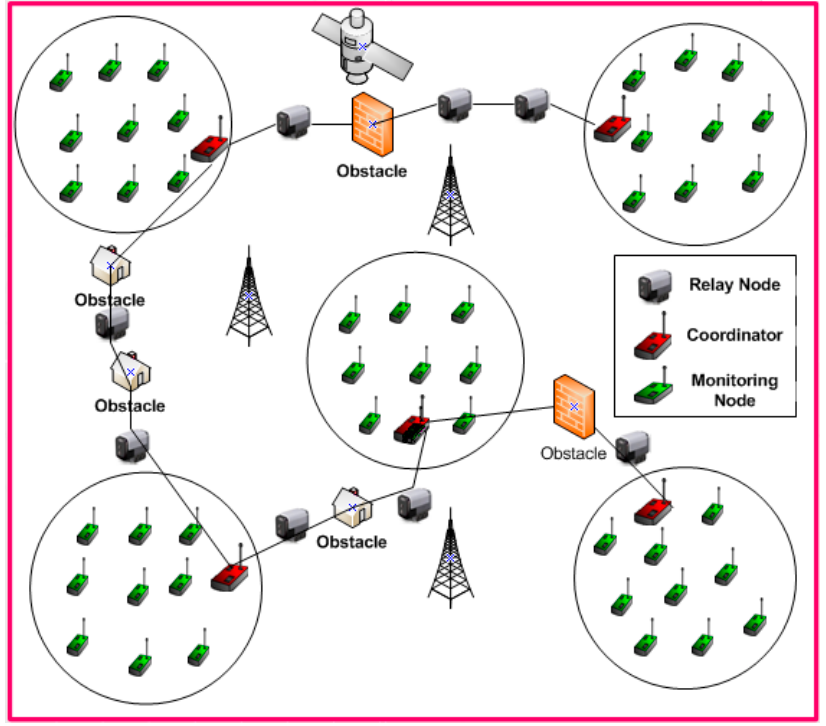
Figure 1. Showing the On-Demand Delivery process and obstacles.